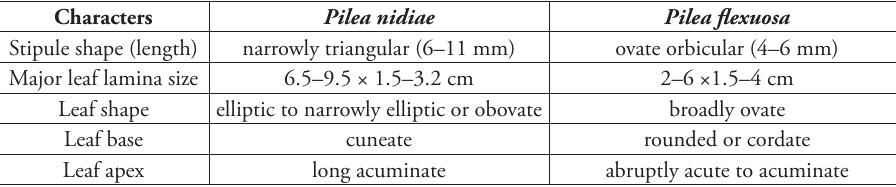
Table 4. Diagnostic characters that distinguish Pilea nidiae and P. flexuosa .